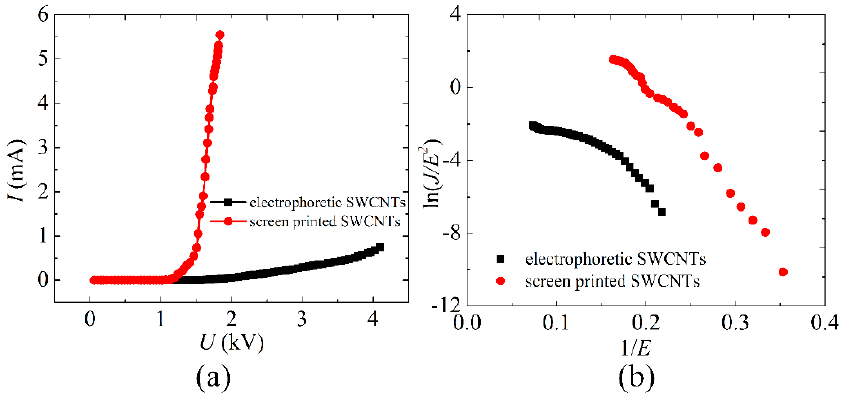
Figure 6. ( a ) The maximum emission current of the screen printed and electrophoretic SWCNT cathodes at DC mode. ( b ) The corresponding F-N plots.